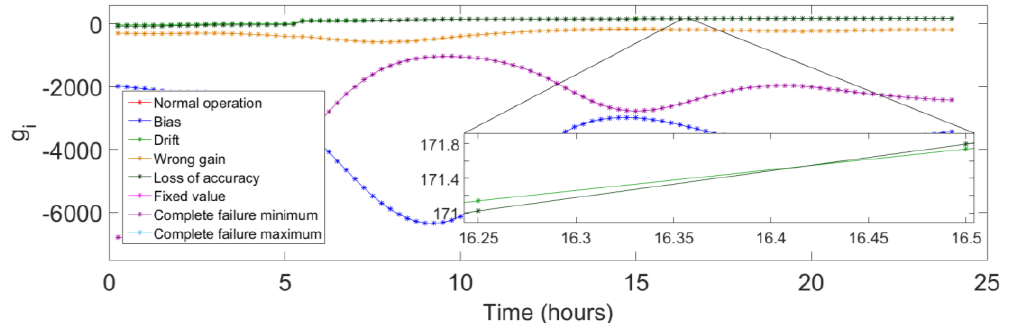
Figure 6. Loss of accuracy diagnosis: graphs of the FDA discriminant functions gi(x) for each of the normal and seven fault classes, along the 24 h of the 140th day and the detailed representation revealing the class of the observations and the time moment of the firm fault type identification.